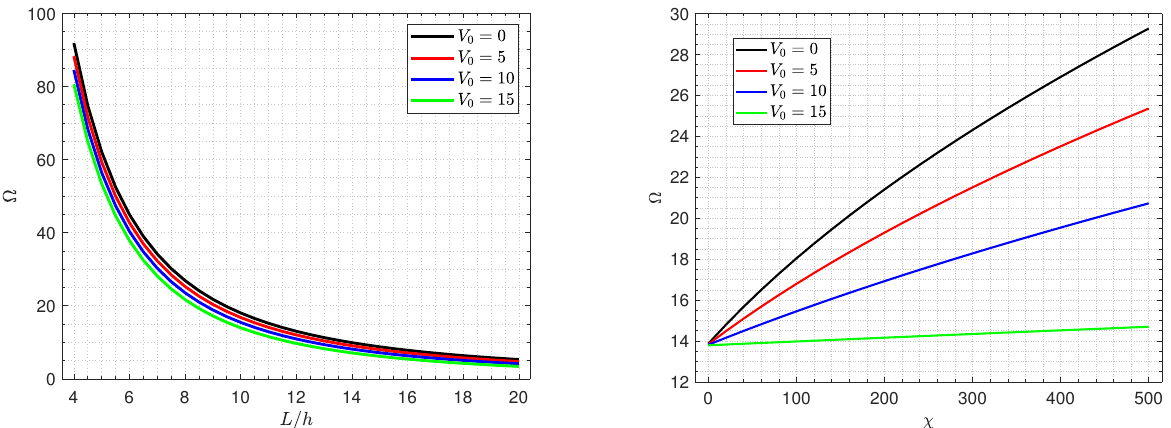
Figure 7. Frequency of the nanocomposite piezoelectromagnetic plate versus the side-to-thickness ratio L / h and the piezoelectromagnetic multiple χ for different values of the external applied electric potential V 0 (Type